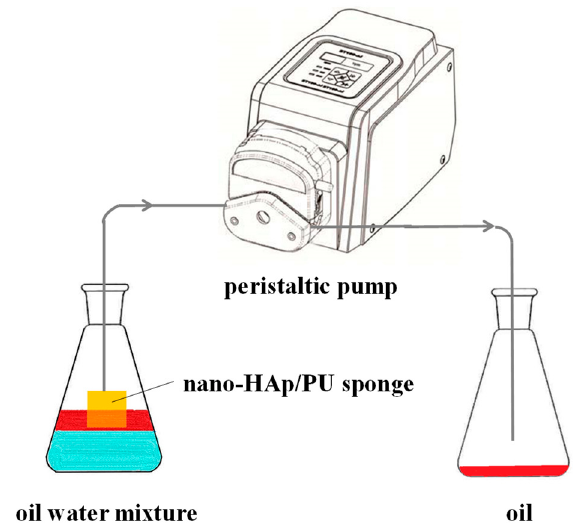
Figure 1. Scheme of the continuous in-situ oil/water separation.